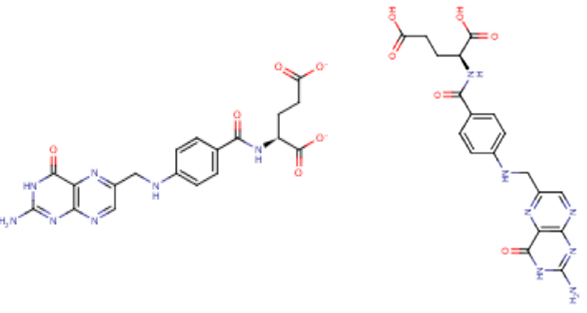
Figure 7. Structures of Folate and folic acid.